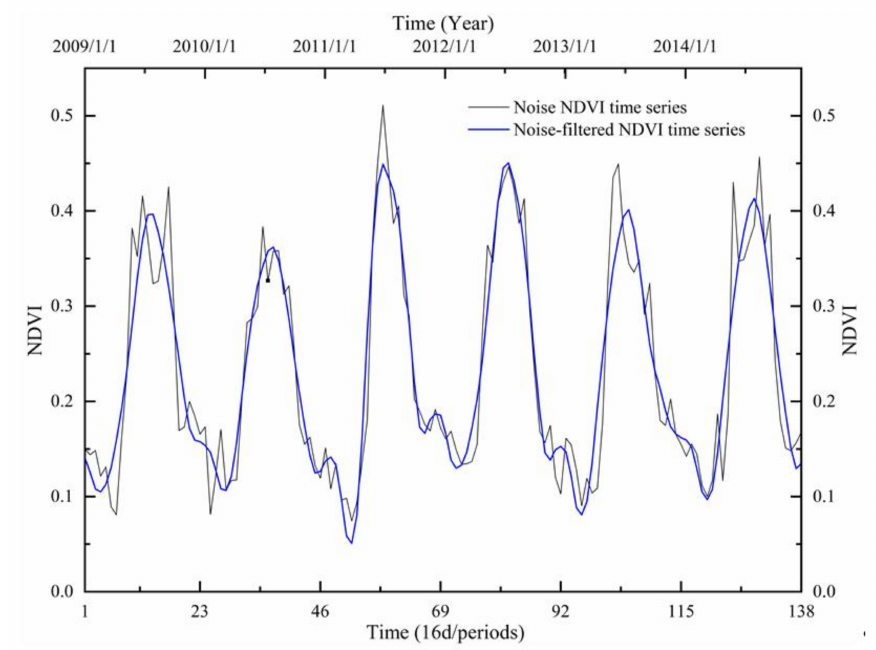
Figure 5. Noise-filtered NDVI time